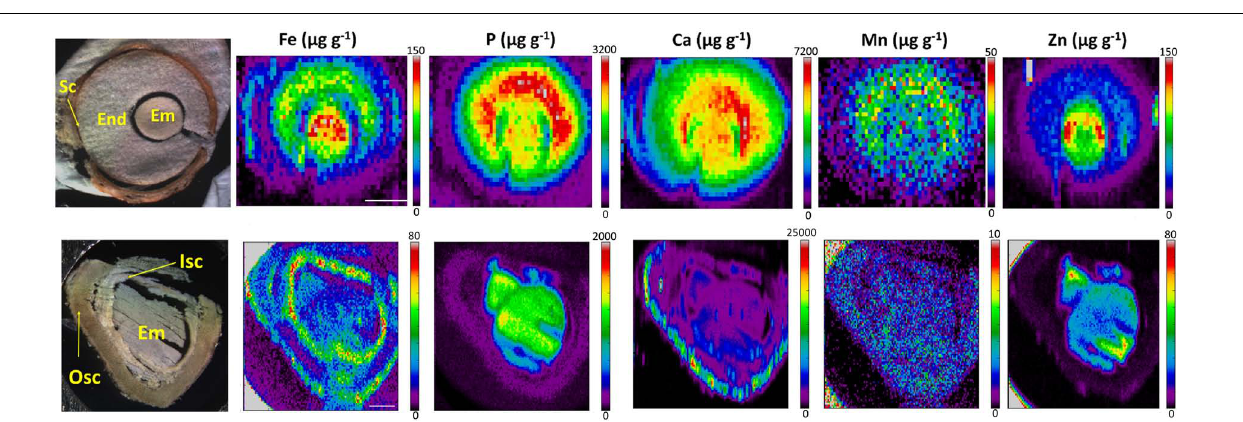
FIGURE 7 | X-ray fluorescence spectroscopy confirms endosperm and seed coat accumulate Fe. Spatial distribution of metals in Euonymus europaeus ( top panel ) and Moringa peregrina ( bottom panel ). The first column of images shows light microscopy images. Other columns show distribution of elements; Fe, P, Ca, Mn, and Zn, respectively. Colorbar indicates concentration. sc, seed coat; en, endosperm; isc, inner seed coat; osc, outer seed coat; em, embryo. Bar is 1